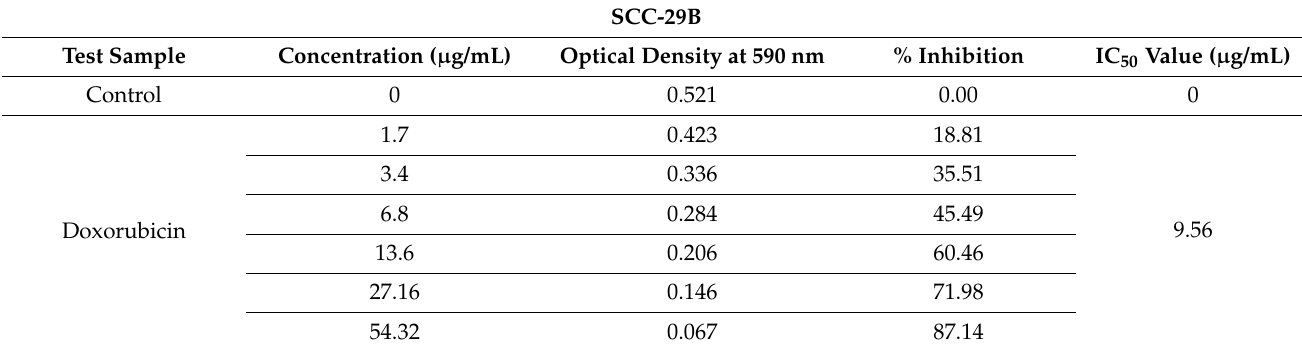
Table 2. MTT assay of doxorubicin and longifolene on